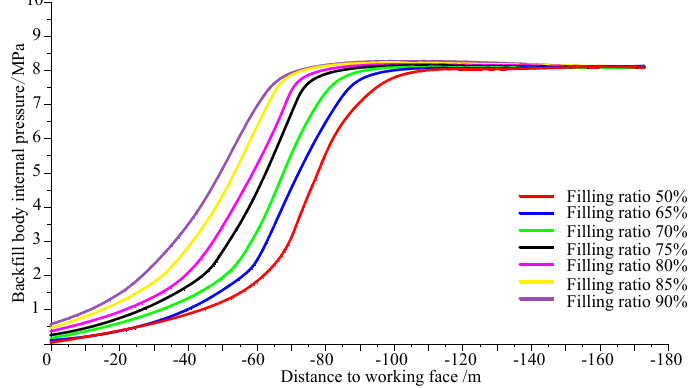
Figure 13. The distribution of backfill body internal pressure under different filling ratios.